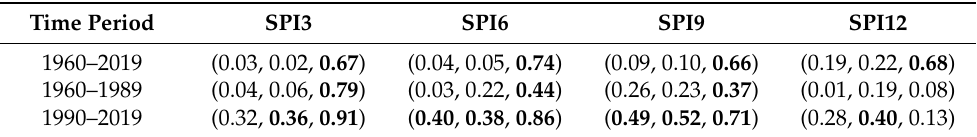
Table 1. Pattern correlations between detected trend in the SPI using one of the three methods and that using another method over three different time periods. The first, second, and third values in each parenthesis indicate correlations derived from the paired methods: linear regression (LR) vs. first derivative; LR vs. locally estimated scatterplot smoothing (LOESS), and first derivative vs. LOESS, respectively. Correlation values greater than 0.35 are in